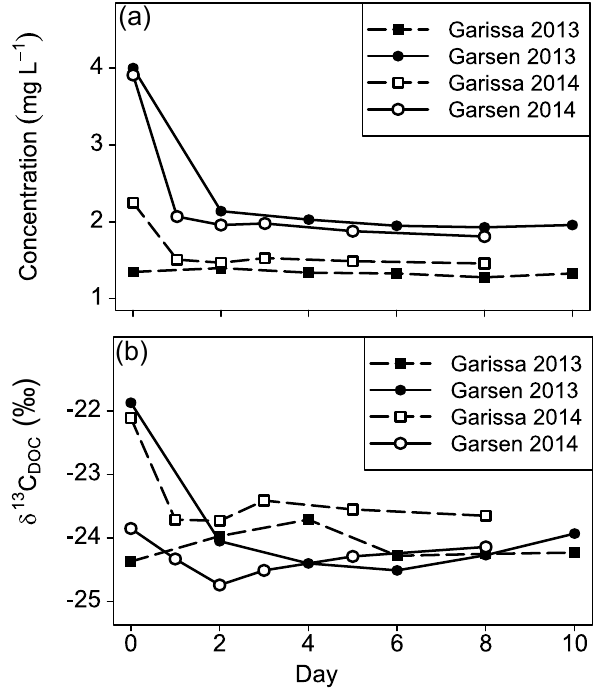
Figure 3. Evolution of (a) DOC concentration and (b) carbon stable isotope signature of DOC ( δ 13 C DOC ) during the 8- to 10-day incu- bations. Both panels show data from one incubation series per sam- pling site and per year (Garissa 26 May 2013, Garsen 26 May 2013, Garissa 29 April 2014, Garsen 6 April 2014), providing representa- tive examples of the low, medium and high response of the DOC. No consistent difference was found between the different sampling sites or sampling years. The full data set and a similar figure with all the incubation series without POC can be found in the Supplement.